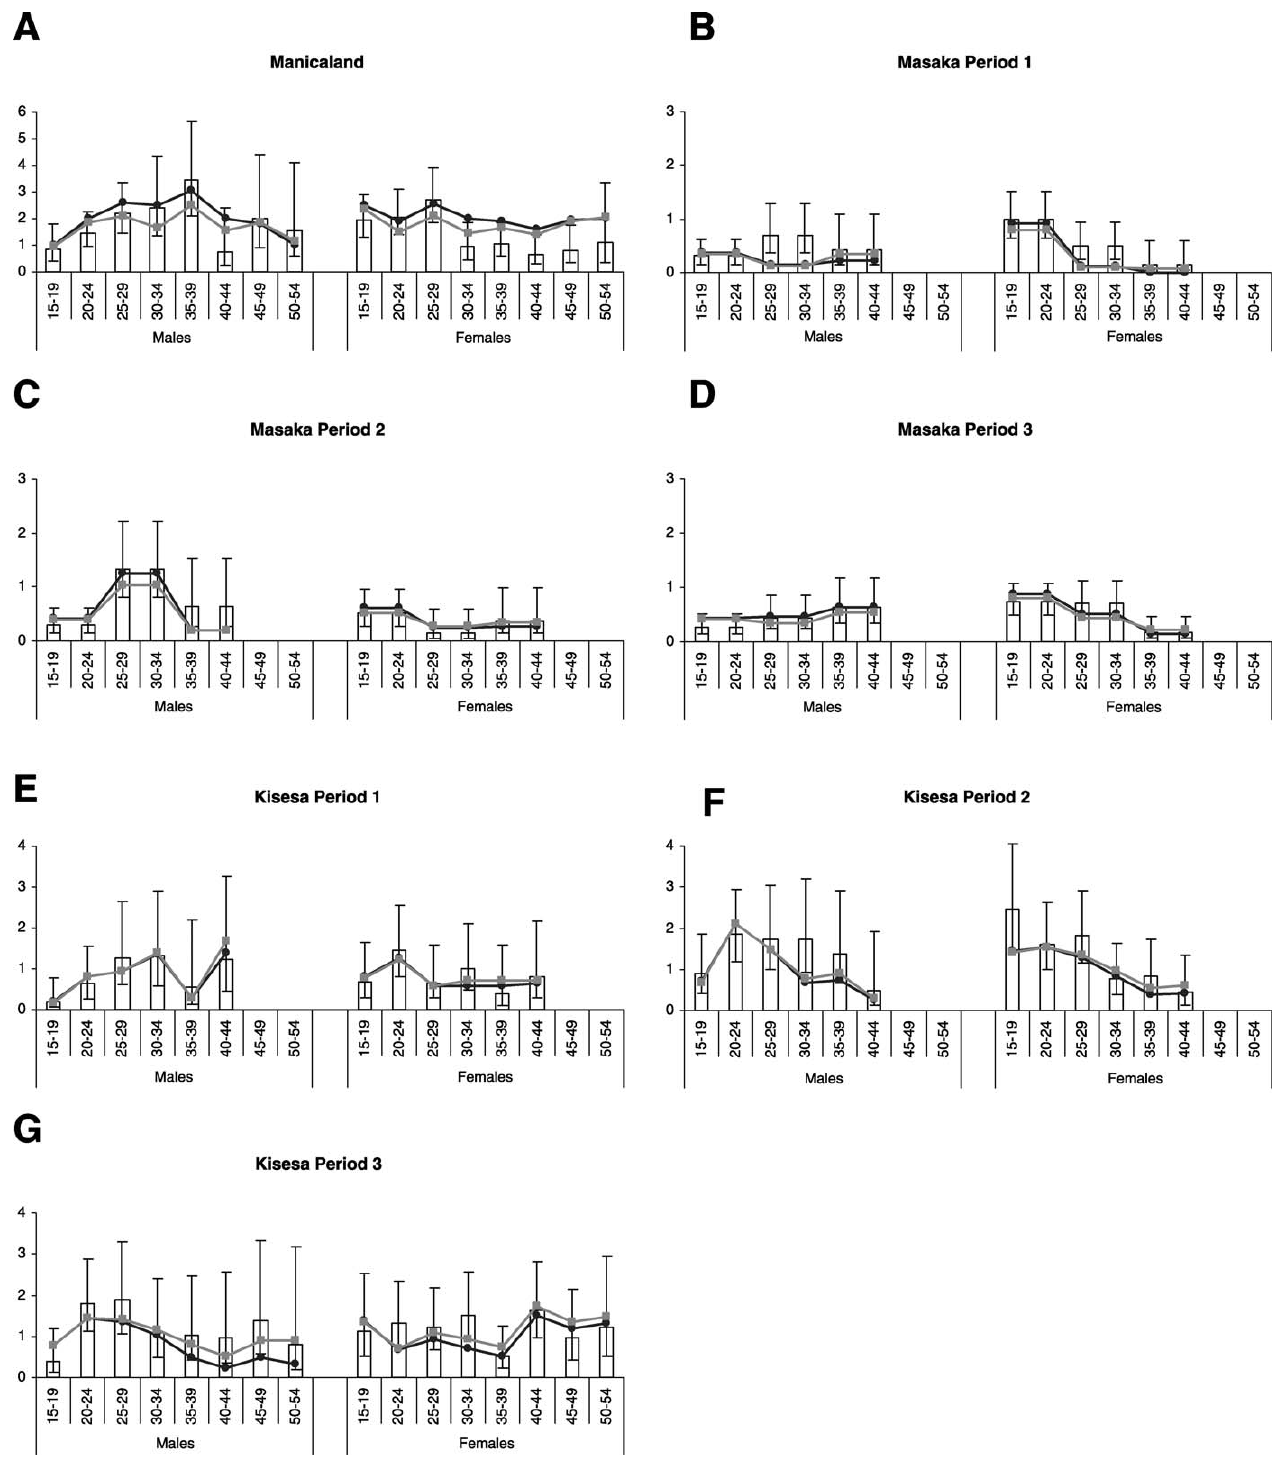
Figure 6. Result from the Cohort Studies Analysis For each graph, the bars show incidence measured in the closed cohort with 95% confidence intervals and the lines show derived incidence estimates using method 1 (dark grey line) and method 2 (light grey line). (A) Manicaland; (B) Masaka, period 1; (C) Masaka, period 2; (D) Masaka, period 3; (E) Kisesa, period 1; (F) Kisesa, period 2; (G) Kisesa, period 3.